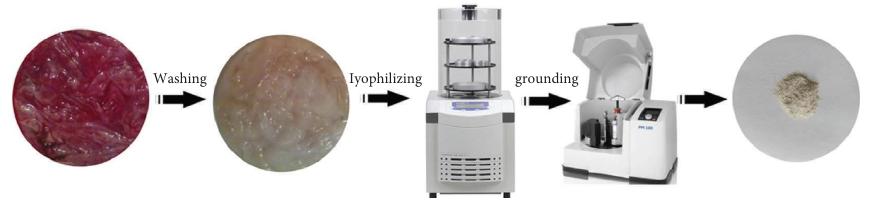
Figure 1: Schematic illustration of the preparation of